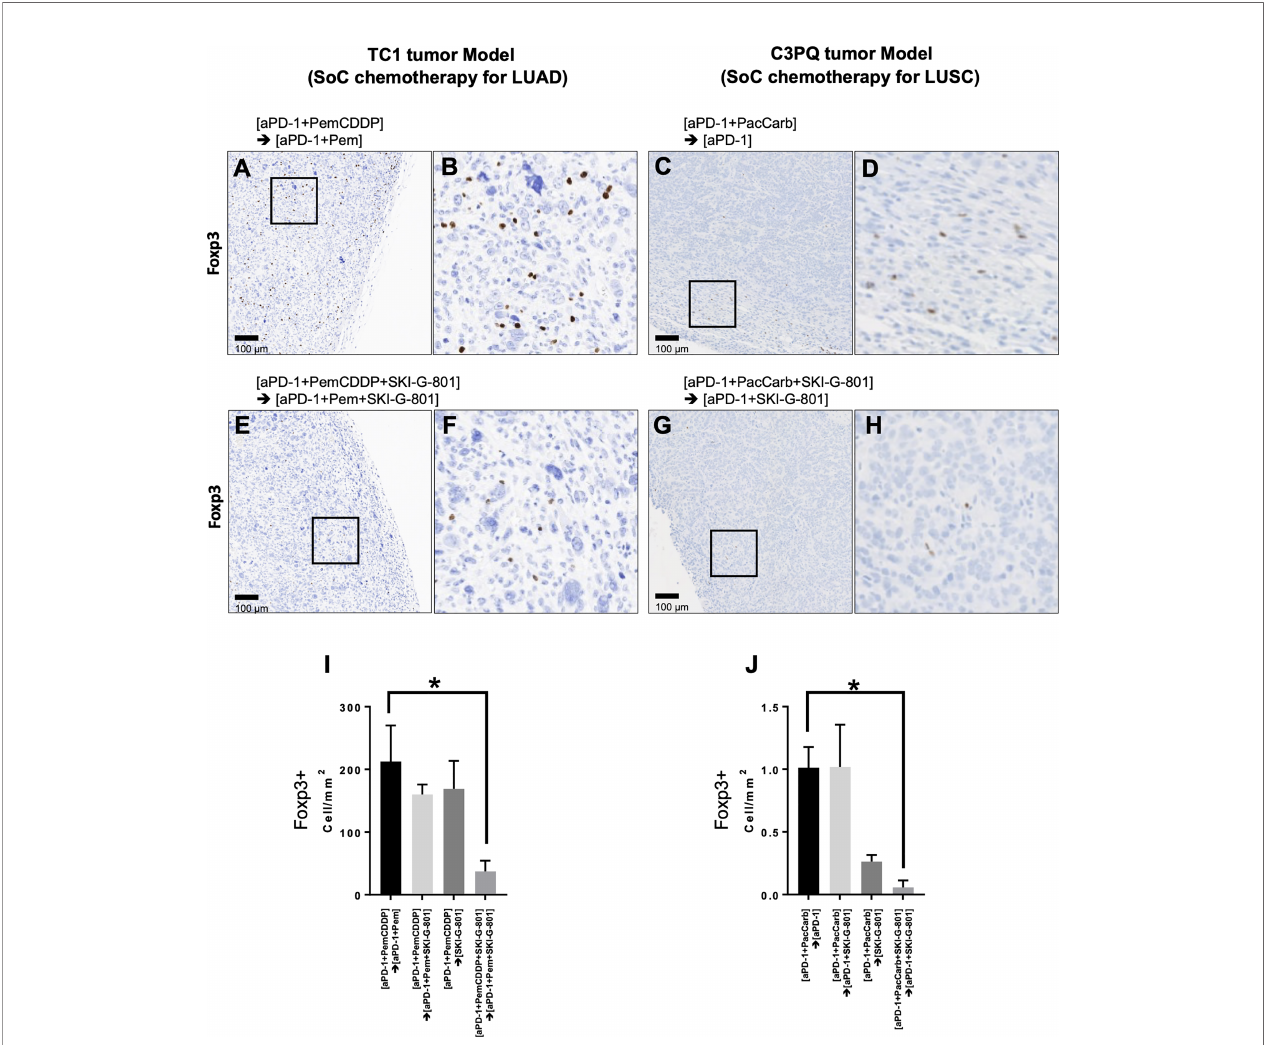
FIGURE 5 | Immunohistochemistry with anti-Foxp3 reveals tumor in fi ltration by regulatory T cells. Positive Foxp3 expression was observed in the [aPD-1 +PemCDDP] ! [aPD-1+Pem] (A) and [aPD-1+PemCDDP+SKI-G-801] ! [aPD-1+Pem+SKI-G-801] (E) groups in TC1 tumor tissues. (B) , Higher magni fi cation of images in (A, F) , higher magni fi cation of images in (E) . In addition, positive Foxp3 expression was visible in the [aPD-1+ PacCarb] ! [aPD-1] (C) and [aPD-1+ PacCarb+SKI-G-801] ! [aPD-1+SKI-G-801] (G) groups in C3PQ tumor tissues. (D) , Higher magni fi cation of images in (C, H) , higher magni fi cation of images in (G) . (I) , the number of Foxp3 + cells per mm 2 of TC1 tumor tissues and (J) , the number of Foxp3 + cells per mm 2 of C3PQ tumor tissues. *p < 0.05. Scale bars in (A, C, E, G) : 100µm. (*p ≤